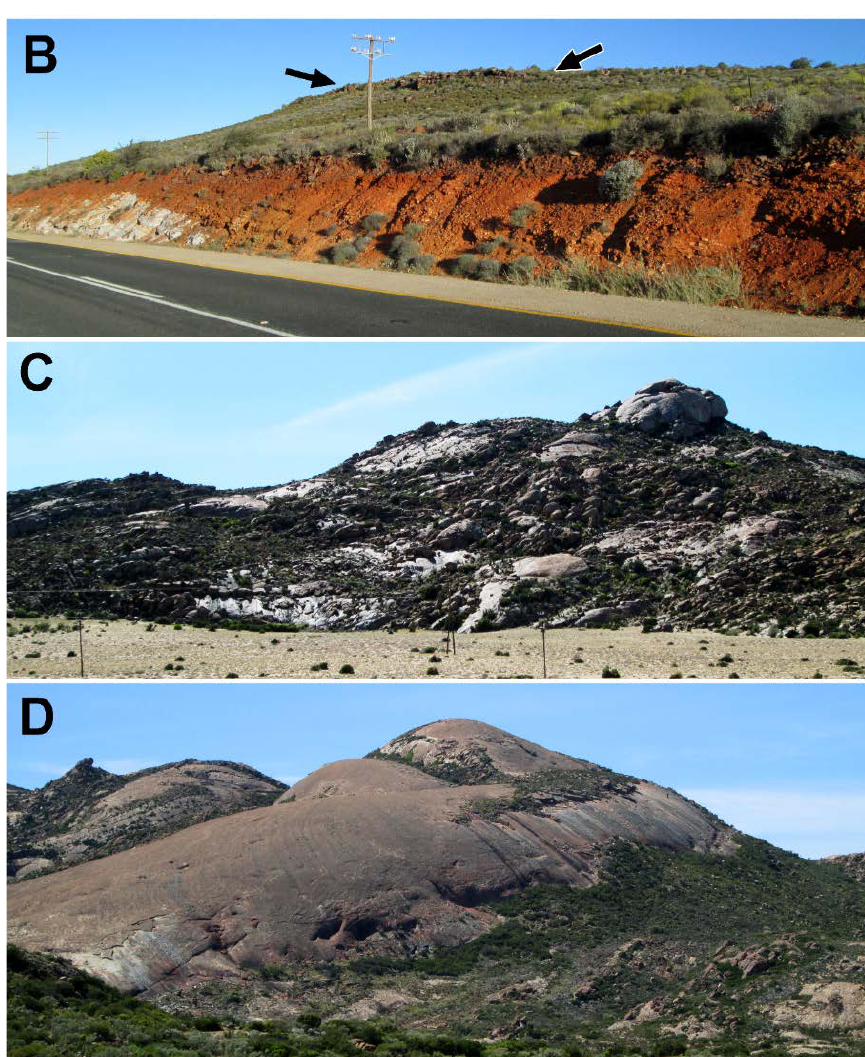
Figure 13. ( A ) View to the north from Nuwerus showing the smooth, curvilinear slope profile. The bedrock in the lower portions of the slope is medium-coarse grained leucocratic granite. Outcrops of quartzite in upper slope locations (black arrows) contribute weathering-resistant, cobbly colluvium that armours the lower surfaces, facilitating entrapment of dust, formation of thick soils, development of a smooth slope profile, and a continuous vegetation cover; ( B ) Exposure on the south side of Highway R382, 6 km northwest of Steinkopf, Northern Cape Province (coordinates: −29.22874° S, 17.69074° E). Weathering-resistant quartzite strata (late Proterozoic Nama group) prominently outcrop at the top of the hill (black arrows). The exposure reveals a continuous layer of cobbly quartzite colluvium on the surface, beneath which are at least two buried soils, indicating multiple episodes of colluviation followed by dust accumulation and soil formation. The bedrock beneath the soils is shale; ( C ) View to the east from Highway N7 south of Springbok showing the corestone topography of a granitic terrain where a source of weathering-resistant, coarse colluvium is not present; ( D ) View to the east from Highway N7 south of Springbok showing a granitic dome (bornhardt), also in a terrain devoid of rock units that can contribute coarse, weathering-resistant colluvium. Notice the occurrence of sheeting in the lower left. Although portion of the dome is mantled by colluvium (lower right) and such a mantle may have at one time been more extensive, under the current climate regime, such a mantle may be undergoing progressive stripping due, in part, to the ease at which colluvium derived from granite is weathered and eroded.